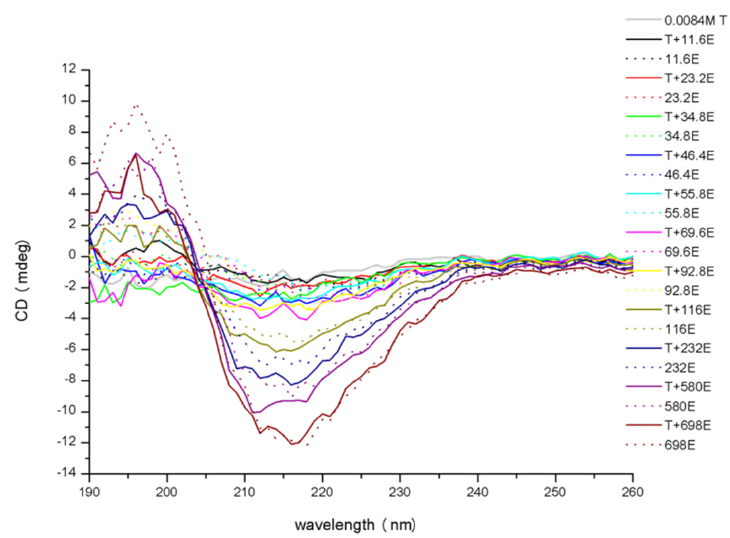
Figure 4. The CD spectra of trypsin in the presence and absence of EGCG.